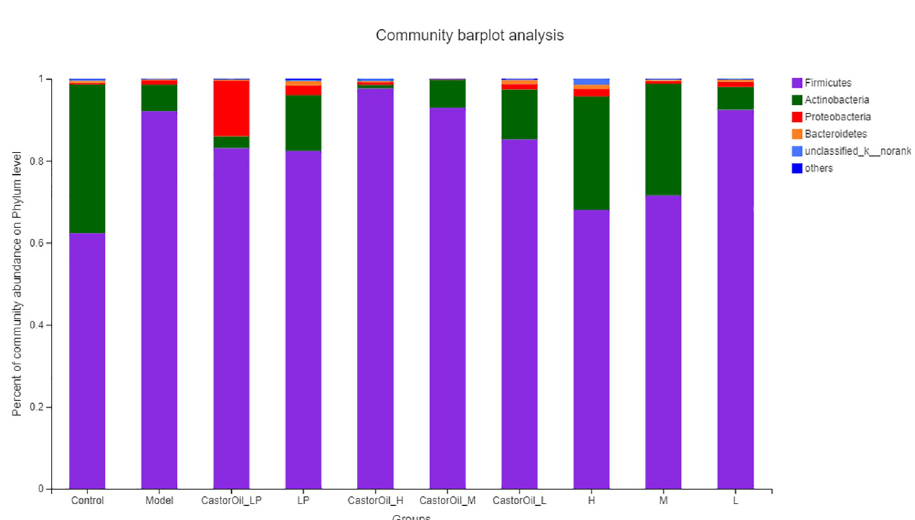
Fig 6. Bar plot analysis of phylum level communities in phylum level. LP (loperamide), H (high dose of FengLiao), M (medium dose of FengLiao), L (low dose of FengLiao). 1 g/ml FengLiao (H), 0.5 g/ml FengLiao (M), 0.25g/ml FengLiao (L) and 5mg/kg loperamide were pretreated in CastorOil_H, H, CastorOil_M, M, CastorOil_L, L, CastorOil_LP, LP groups once a day for three days respectively. 30 min after the last drug administration, 0.5ml castor oil was used to induce diarrhea in CastorOil_H, CastorOil_M, CastorOil_L and CastorOil_LP groups for 4 h and the intestinal contents were sequenced for bacterial 16S rRNA. Bar graph shows percent of community abundance on phylum level.X axis represent groups’ name, Column represents the mean of five mice.